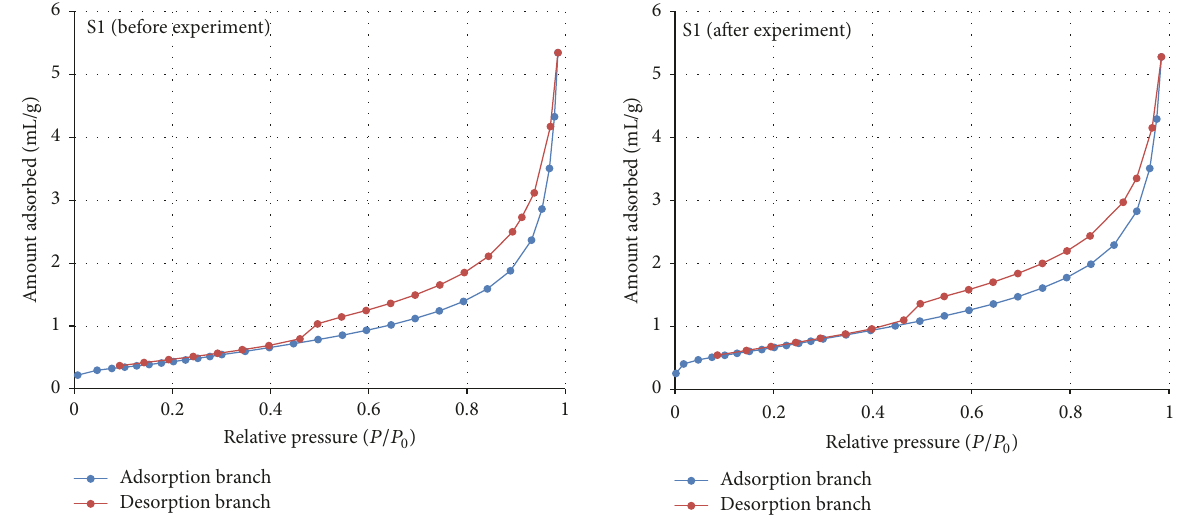
Figure 11: N 2 adsorption-desorption isotherms of S1.